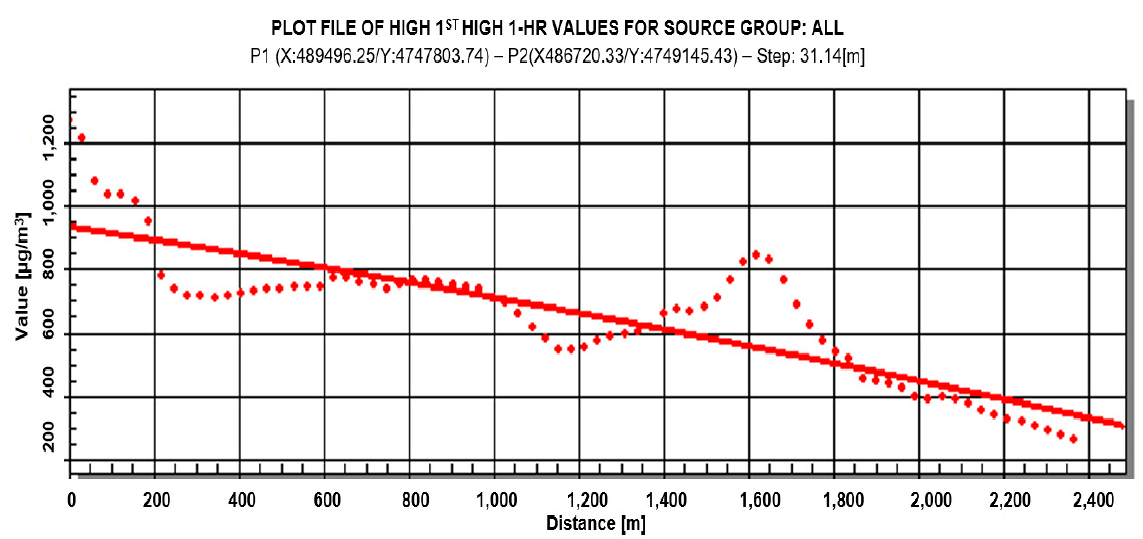
Figure 9. The highest concentration plot in the southwest direction.